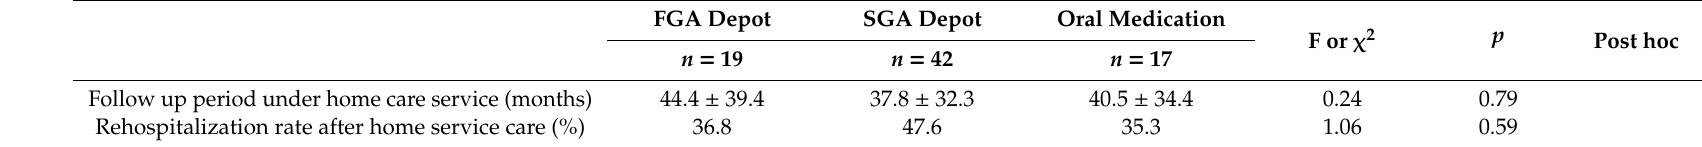
Table 2. Hospitalization data before and after entering home care services.